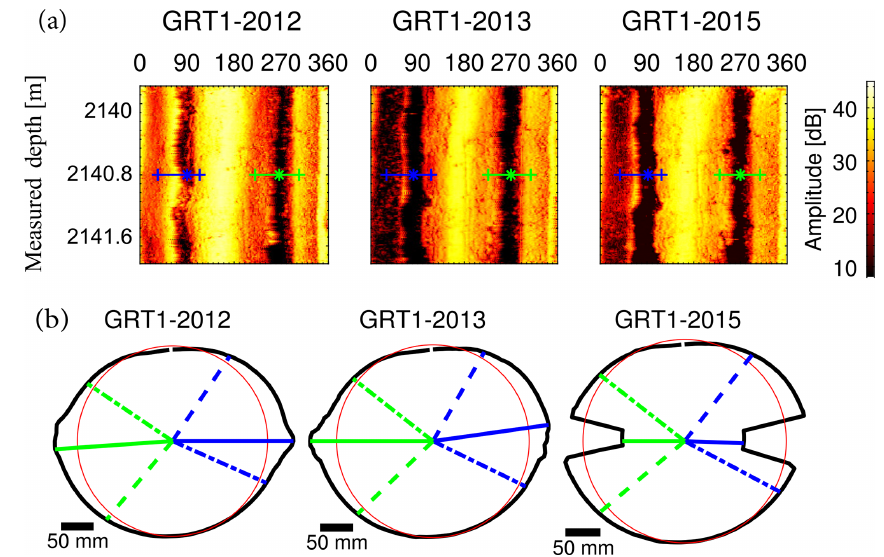
Figure 5. Example of breakout geometry determination in sandstones. (a) Amplitude images for GRT-1 at 2140.8m for the logs from 2012, 2013 and 2015. (b) Wellbore section at 2140.8m computed from the transit time images from the 2012, 2013 and 2015 logs, respectively. The breakout extent is determined on the wellbore section. The blue and green dashed lines represent the extent of the breakout, while the plain lines represent the azimuth of the maximum radial extension of the breakout.